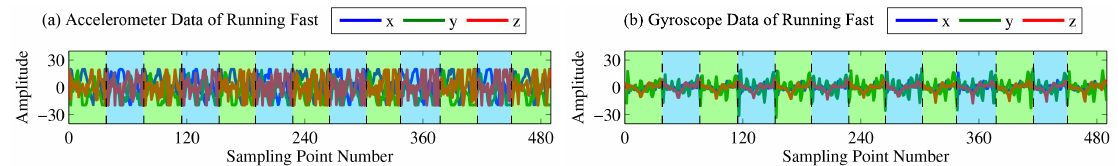
Figure 18. Accelerometer ( a ) and gyroscope ( b ) data of running